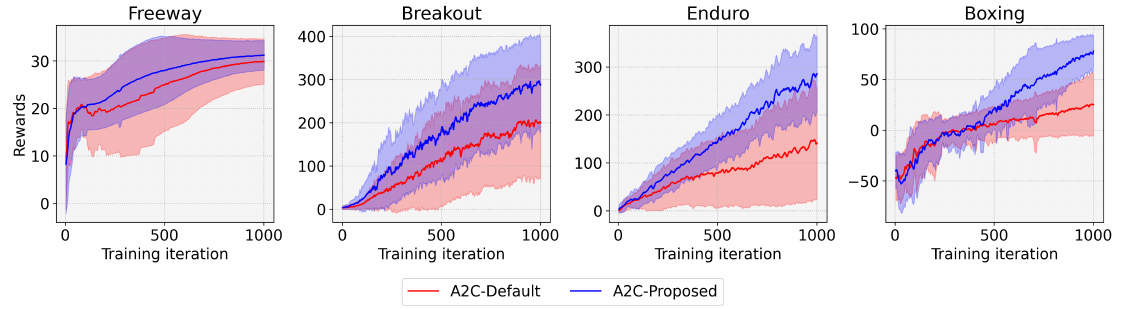
Figure 7. Comparison of the entropy-aware model initialization-based A2C (A2C-Proposed) with the conventional A2C (A2C-Default) for four